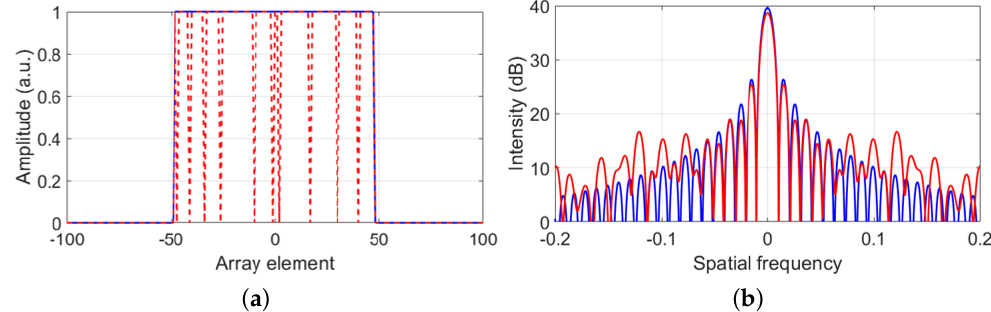
Figure 1. ( a ) Spatial aperture of a 96 − element transducer array with fully working elements (in blue) and 10 inactive elements (in red). ( b ) Fourier transform of the spatial apertures shown in ( a